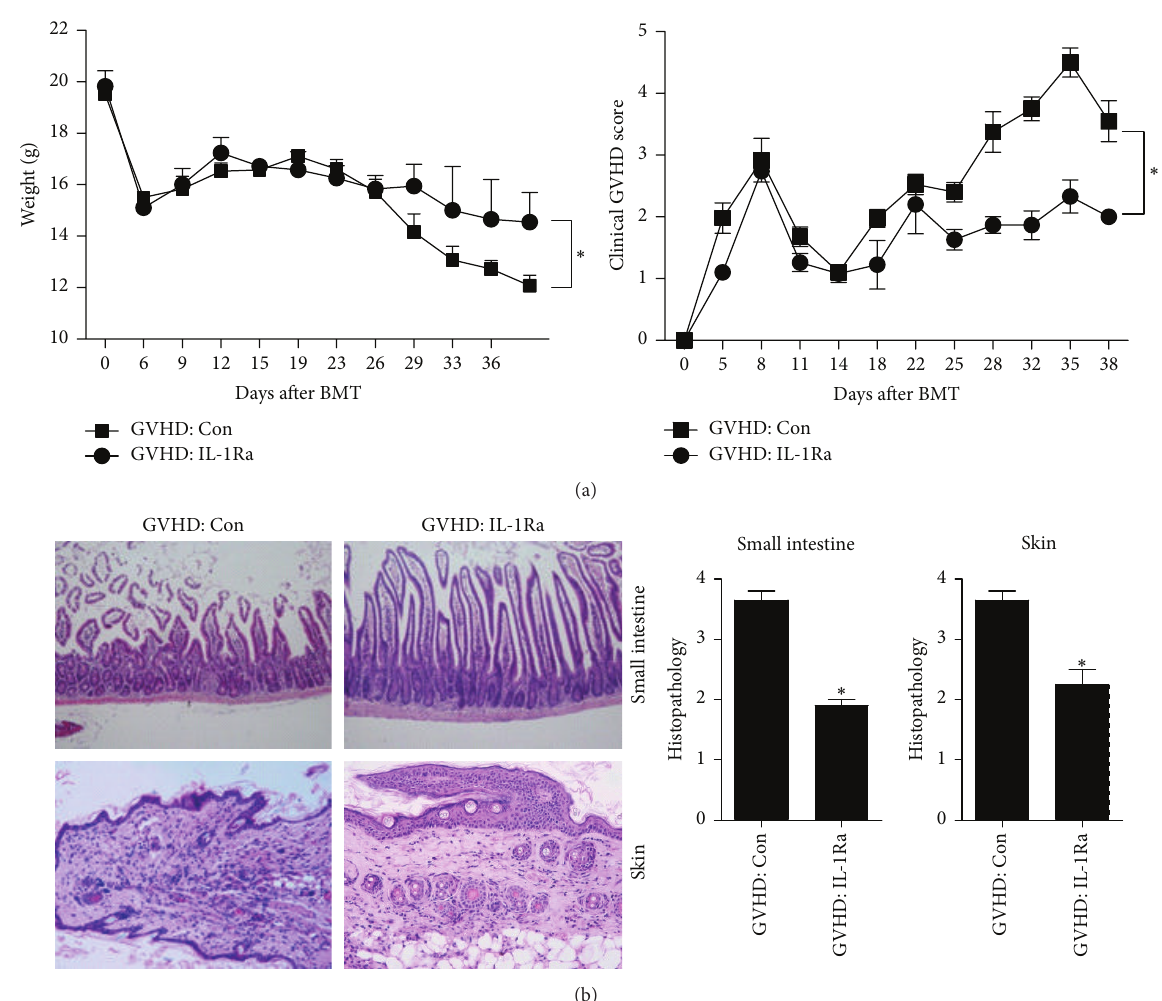
Figure4:BlockadeofIL-1signalingindonorcellsinhibitsseverityofacutegraft-versus-hostdisease(GVHD).(a)Splenocytes(fromC57BL/6 mice) that were cultured with or without IL-1 receptor antagonist (IL-1Ra) for 2 h were transplanted into recipient mice (BALB/c), and the clinical features of acute GVHD were then monitored ( 𝑛 = 5 per group). (b) Twelve days after the bone marrow transplant (BMT), histopathological analysis was performed on the skin and small intestine. ∗ 𝑃 < 0.05 . Data are representative of 2 independent